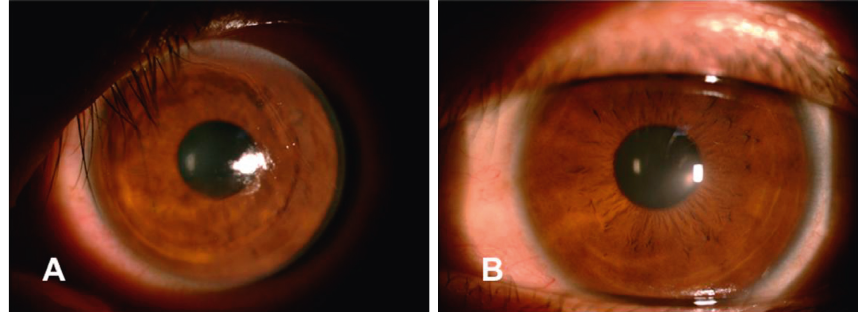
Figure 7: Preoperative and postoperative 24-month follow-up of representative slit-lamp photographs. (A) Representative slit-lamp photographs of patient’s cornea treated with PTK and PRK before the CXL. (B) Slit-lamp photographs of the patient’s cornea at 24-month